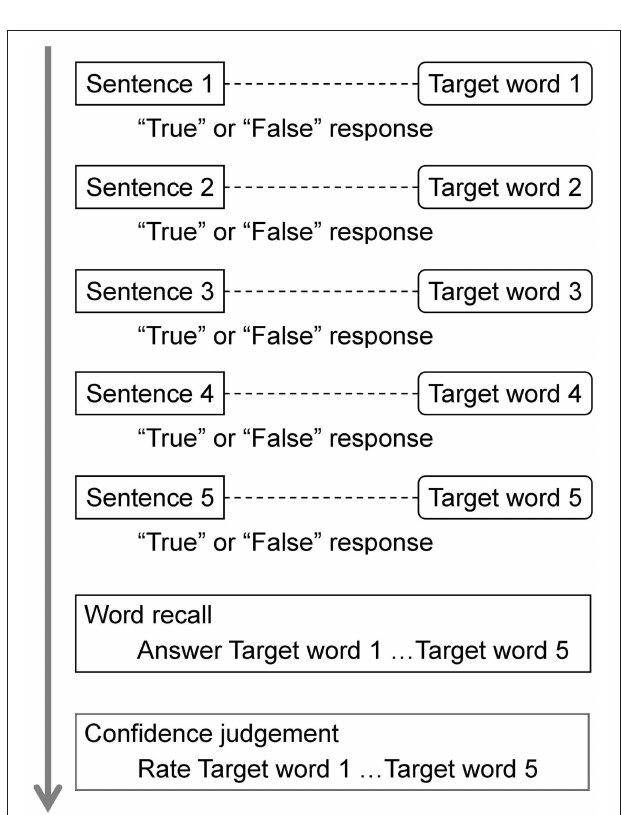
FIGURE 1 | Experimental procedure in the five-sentence condition. On each trial, participants maintained the first word of each sentence, and judged whether each sentence was true or false based on general knowledge. Immediately after the experimenter finished reading a sentence, the true/false decision was written down. At the end of each trial, participants recalled every word they had memorized during that trial, and rated their retrospective confidence for recall performance for each